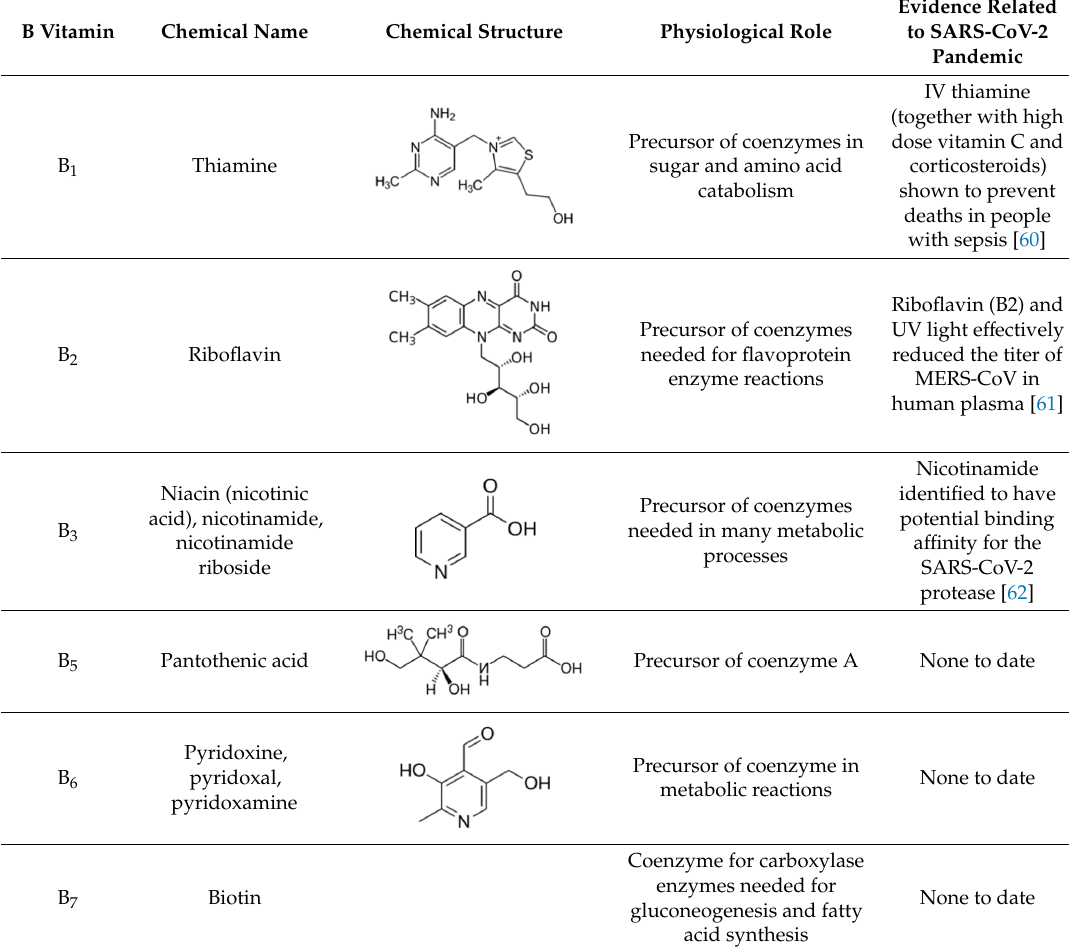
Table 1. Physiological role of the B vitamins.